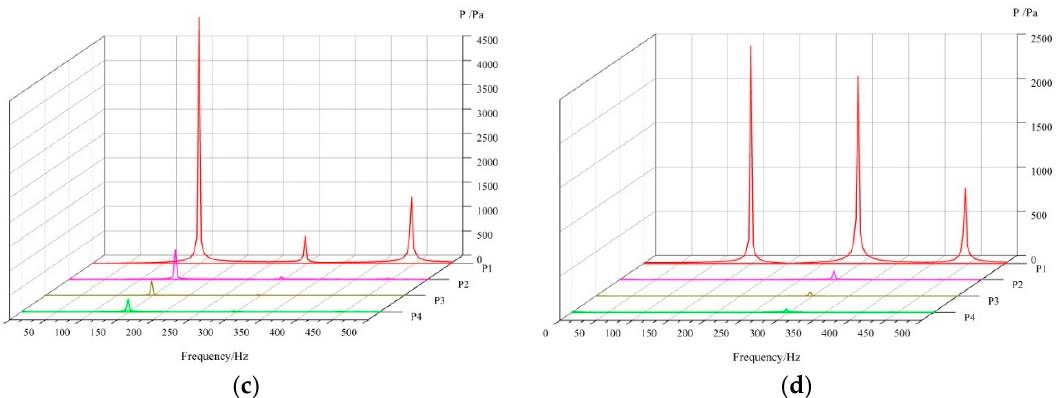
Figure 12. Spectrum analysis of pressure fluctuation in volute for different cases. ( a ) Case0; ( b ) Case10; ( c ) Case20; ( d ) Case30.